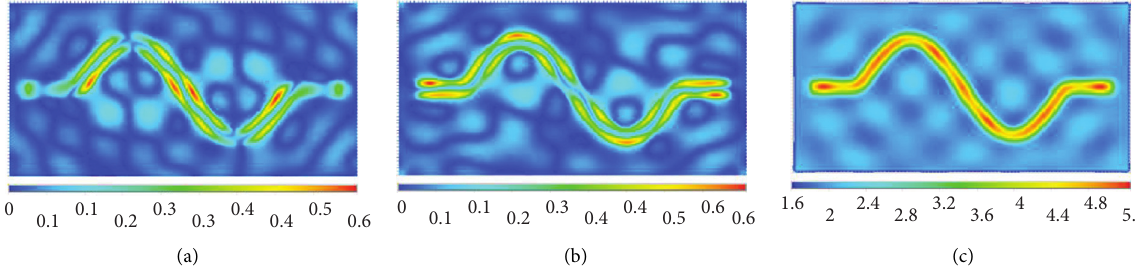
Figure 29: P wave incident ( H � 150m, f � 2.0Hz, C